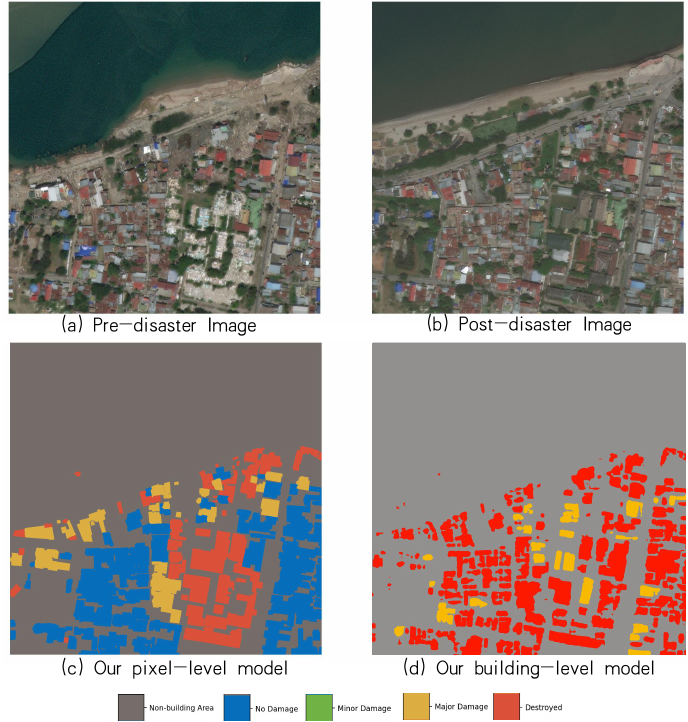
Figure 9. A case study of different level models evaluated in the pixel-level.